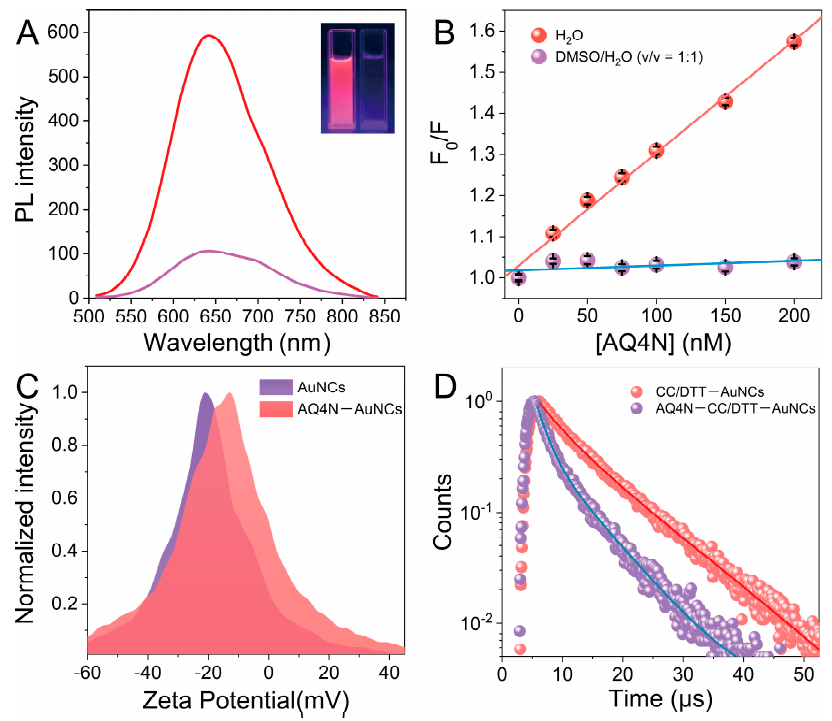
Figure 2. ( A ) The photoemission spectra of CC/DTT-AuNCs (red line) and CC/DTT-AuNCs + 1 μ M AQ4N (blue line). Inset shows the photographs of CC/DTT-AuNC solutions without (left) and with (right) the introduction of 1 μ M AQ4N under a 254 nm UV light. ( B ) The effect of solvent polarity on the luminescence suppression of AQ4N-CC/DTT-AuNCs system. ( C ) Zeta potentials of CC/DTT-AuNCs in the absence and presence of 10 μ M AQ4N. ( D ) Emission decay profiles of CC/DTT-AuNCs and CC/DTT-AuNCs + 1 μ M AQ4N.